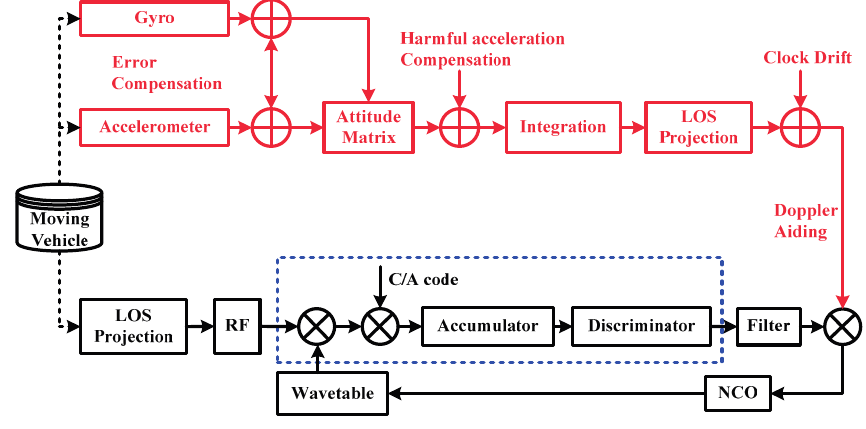
Figure 4. Principle of INS-aided PLLs. C/A code,